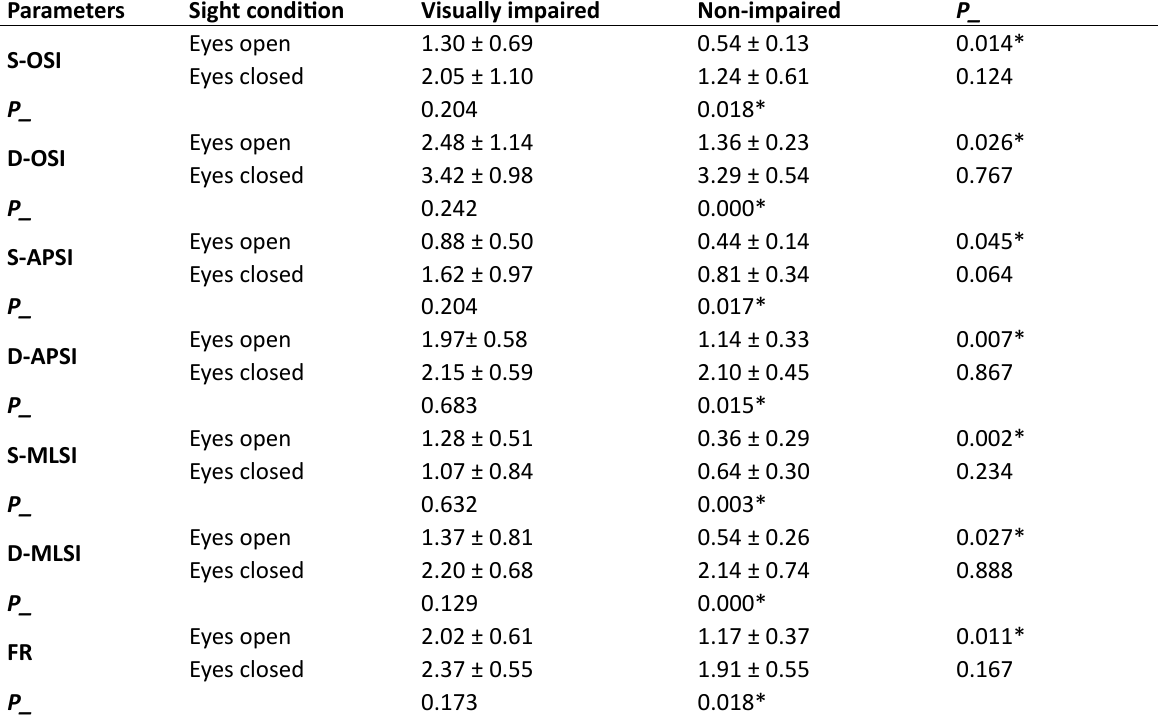
S-OSI: Static overall stability index; D-OSI: Dynamic overall stability index; S-APSI: Static anterior-posterior stability index; D-APSI: Dynamic anterior-posterior stability index; S-MLSI: Static medial-lateral stability index; D-MLSI: Dynamic medial-lateral stability index; FR: Fall